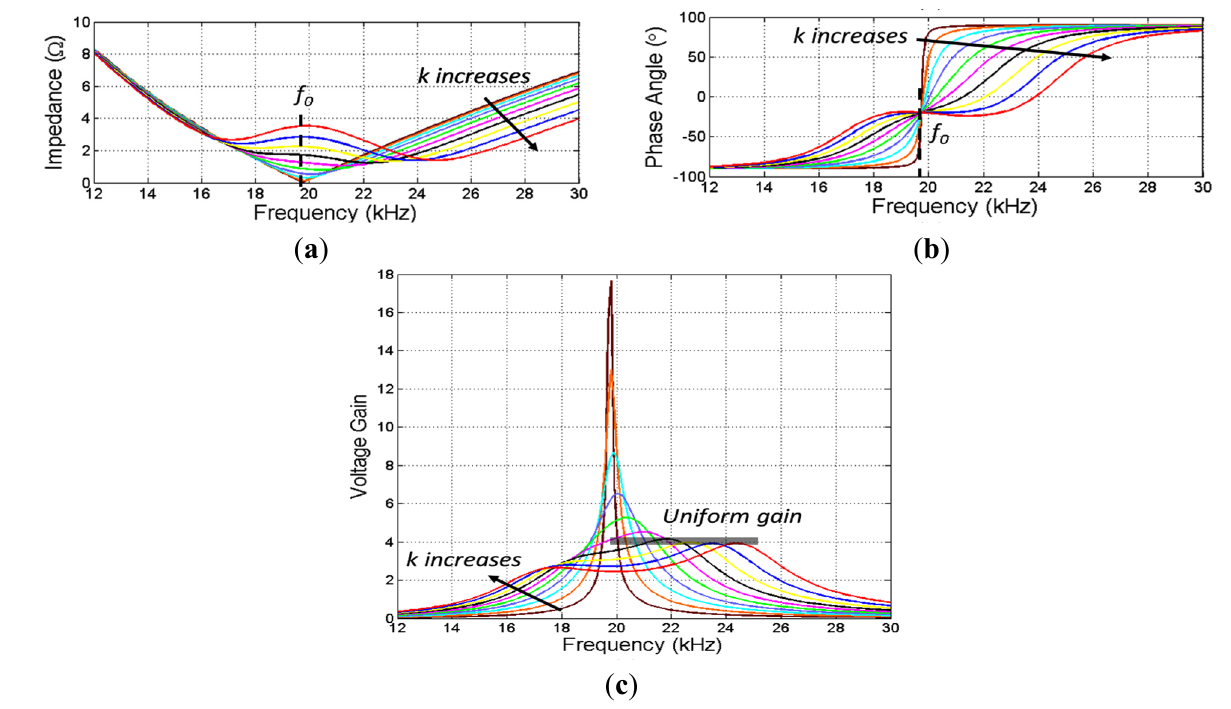
Figure 4. Impedance and voltage gain G in frequency domain. ( a ) Impedance magnitude; ( b ) Impedance phase characteristics; ( c ) Voltage gain in frequency domain. The